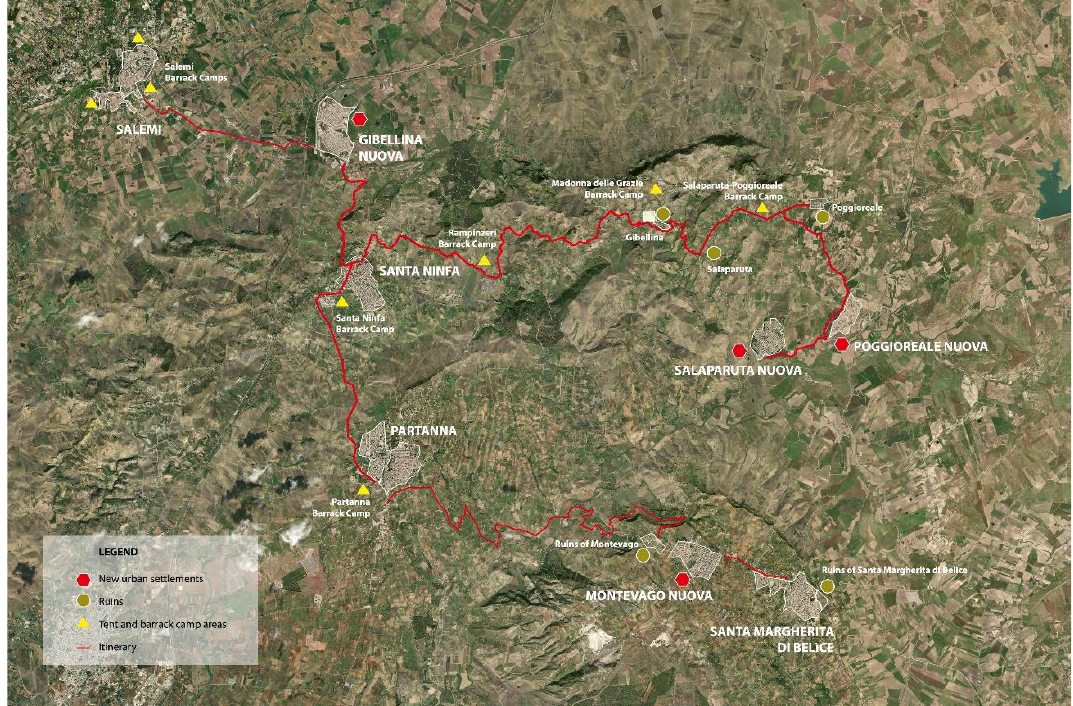
Figure 13. Selected locations and itinerary. Source: our elaboration on Google base map.